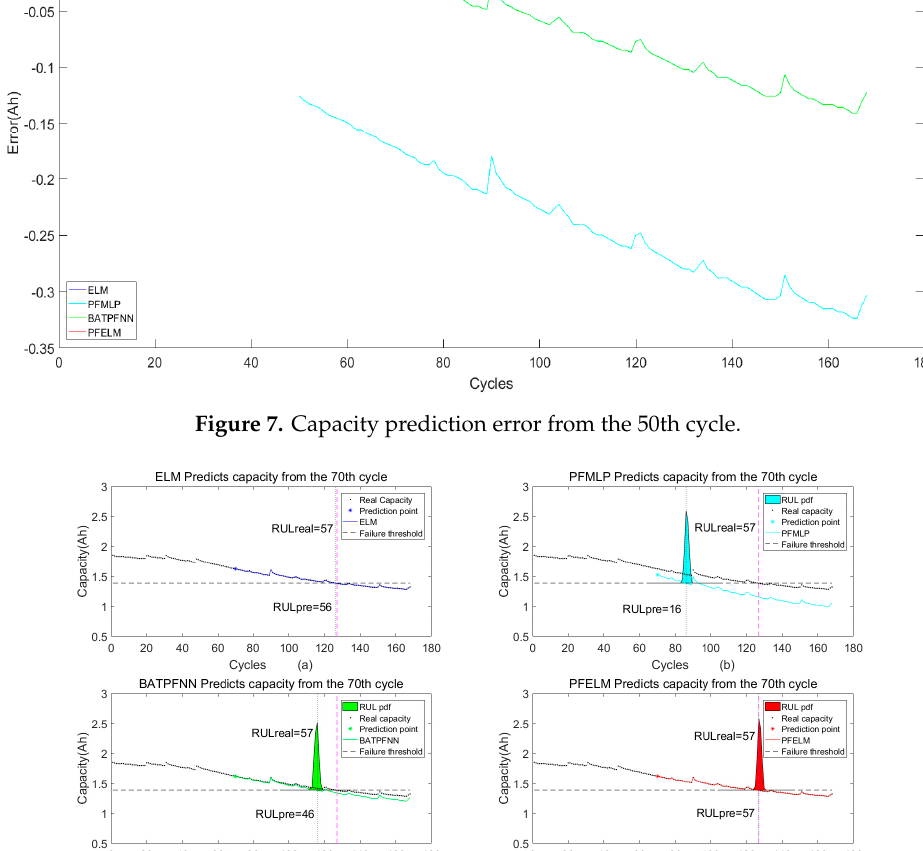
Figure 8. Predicting capacity from the 70th cycle by di ff erent algorithms: ( a ) ELM ; ( b ) PFMLP; ( c ) BATPFNN; ( d )